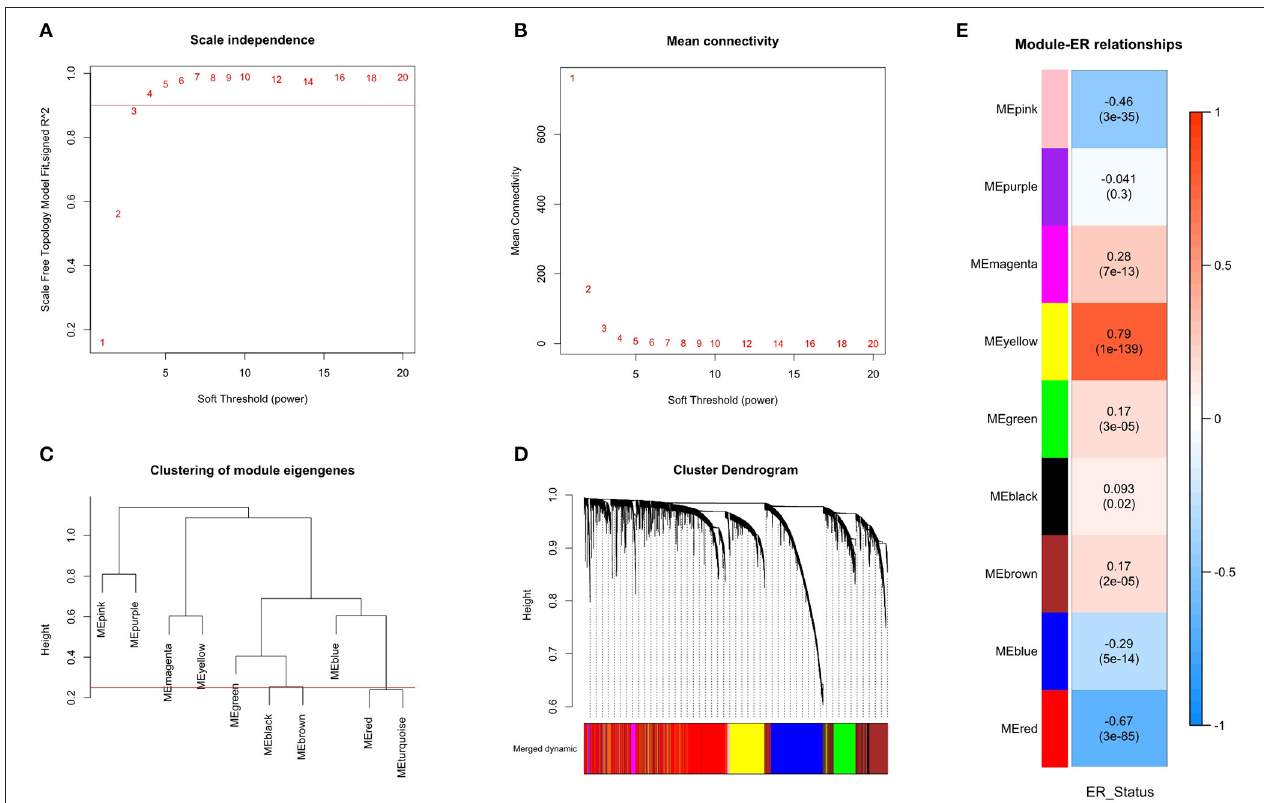
FIGURE 3 | Identification of modules associated with the ER_Status of breast cancer. (A) The scale-free fit index for various soft-thresholding power. Scale-free topology (SFT) was achieved when the recommended soft-thresholding power was 3. (B) The mean connectivity for various soft-thresholding powers. (C) The cluster dendrogram of module eigengenes. (D) The cluster dendrogram of all genes with corresponding color assignments. Nine colors present nine modules. (E) Module-ER_Status relationship heatmap. The values above the brackets represent the correlation coefficients between modules and ER_Status. The values in brackets are the P -values for the association test. The red and yellow modules were significantly related to the ER_Status and selected as the important